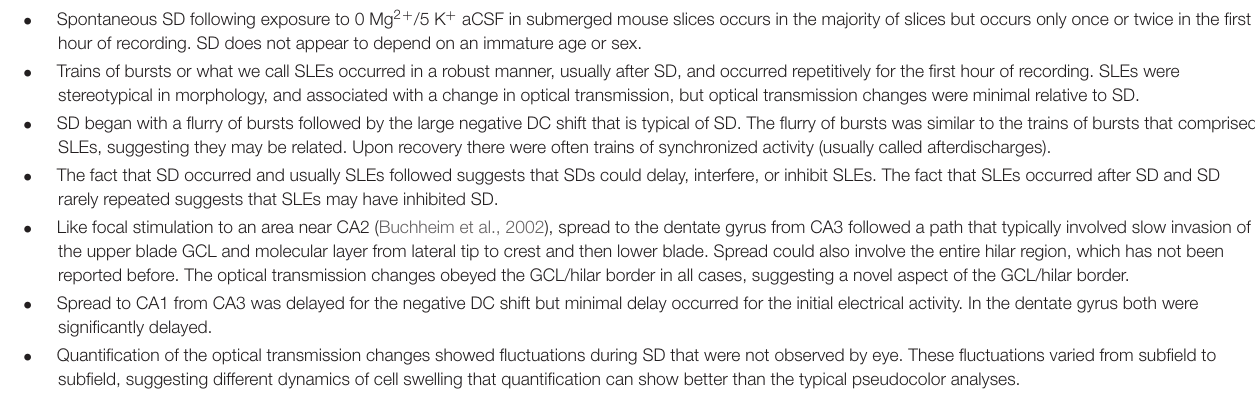
FIGURE 6 | SDs but not SLEs, show prominent changes in light transmission. (A1) Schematic of the path of light transmission in panel A2. Arrow indicates the propagation of the observed SD. (A2) Change of light transmission initiated in CA3 (solid line) and then followed by CA1 (dashed line) with a delay. (B1) Schematic of the region of interests (stars) in panel B2. (B2) A SLE showed subtle changes in light transmission (expanded in b ) without a long delay between CA3 (solid line) and CA1 (dashed line). (C) SDs had significantly higher changes in light transmission than SLEs [two-way ANOVA, SD vs. SLEs, F (1,34) = 12.69, p = 0.0011; CA3 vs. CA1, F (1,34) = 0.34, p = 0.3376; interaction, F (1,34) = 0.3585, p = 0.5533]. TABLE 2 | Summary of new